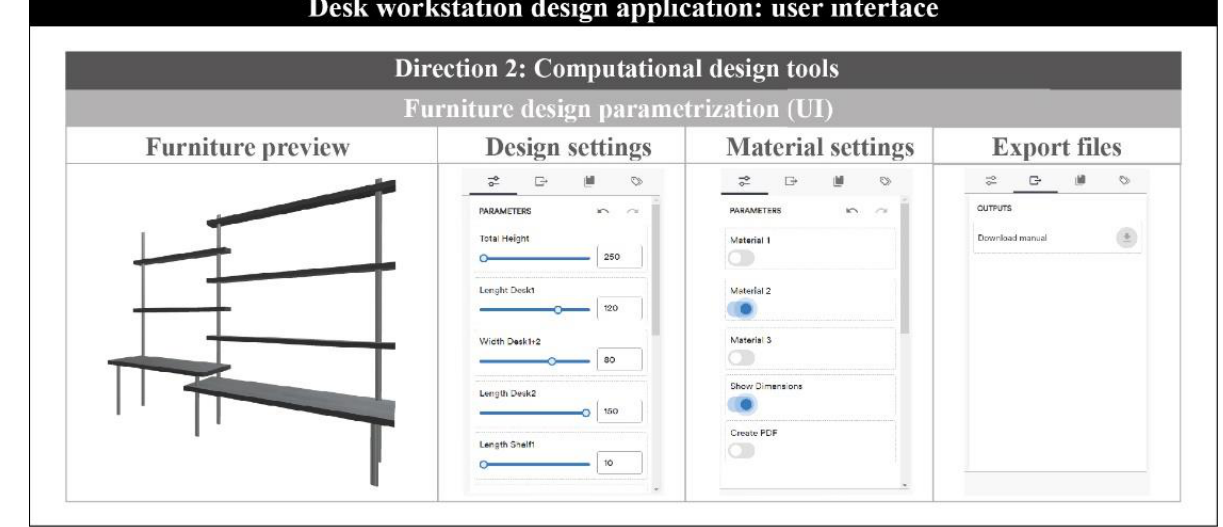
Figure 8. Desk workstation design application as created with Shape Diver TM .